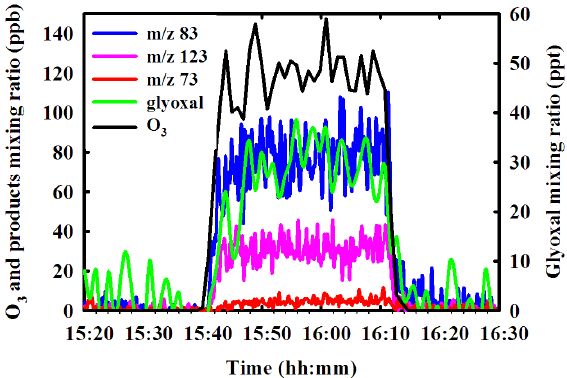
Fig. 4. Example of ozone and product profiles for a Type 1 LA experiment.